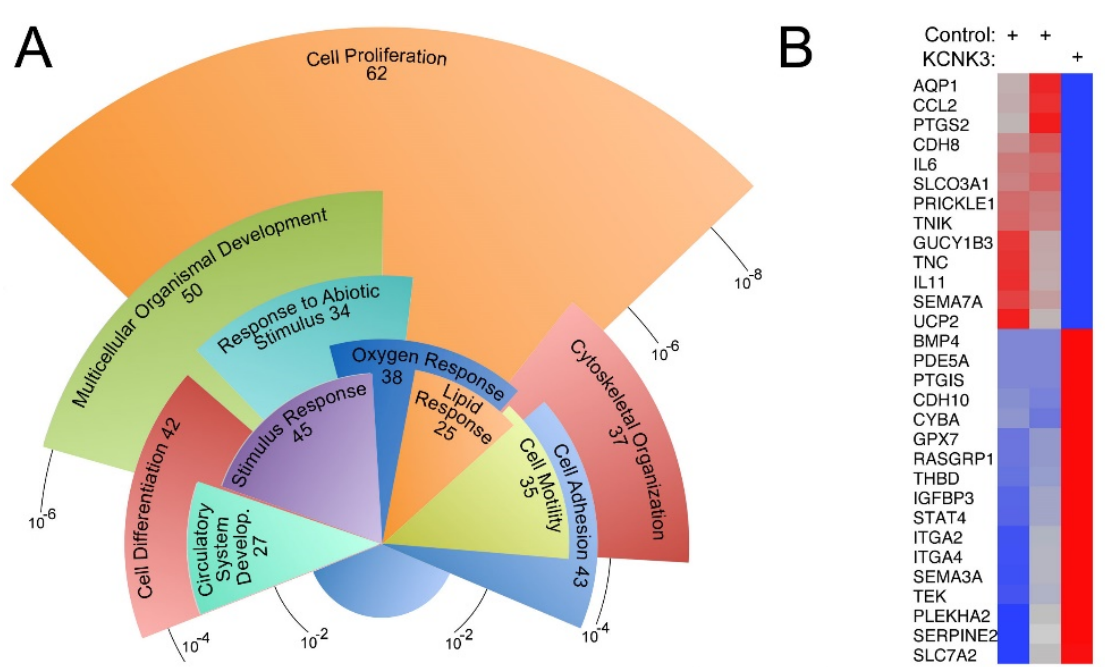
Figure 1. Expression arrays comparing iPSC-derived mesenchyme from a patient carrying a KCNK3 mutation to two controls. ( A ) Overrepresented gene ontology groups from 242 genes with 2-fold changed expression (up or down) in the KCNK3 patient compared to controls. Radius corresponds to multiple-comparisons adjusted p -value; angular width corresponds to number of genes. ( B ) Heat map of 30 genes whose pathways had been previously implicated in pulmonary arterial hypertension, related to vascular tone, metabolism, and inflammatory cell recruitment or adhesion. Red indicates higher expression, blue lower expression.